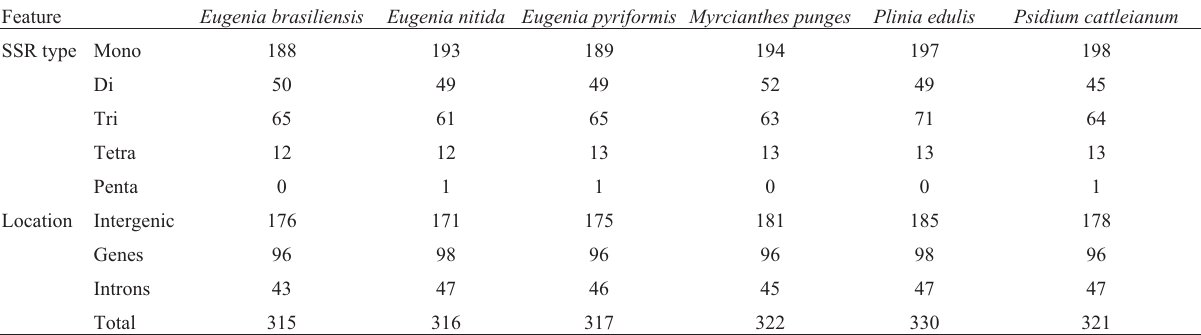
Table 2 - Types, locations, and numbers of SSRs in the chloroplast genomes of six Myrteae species.